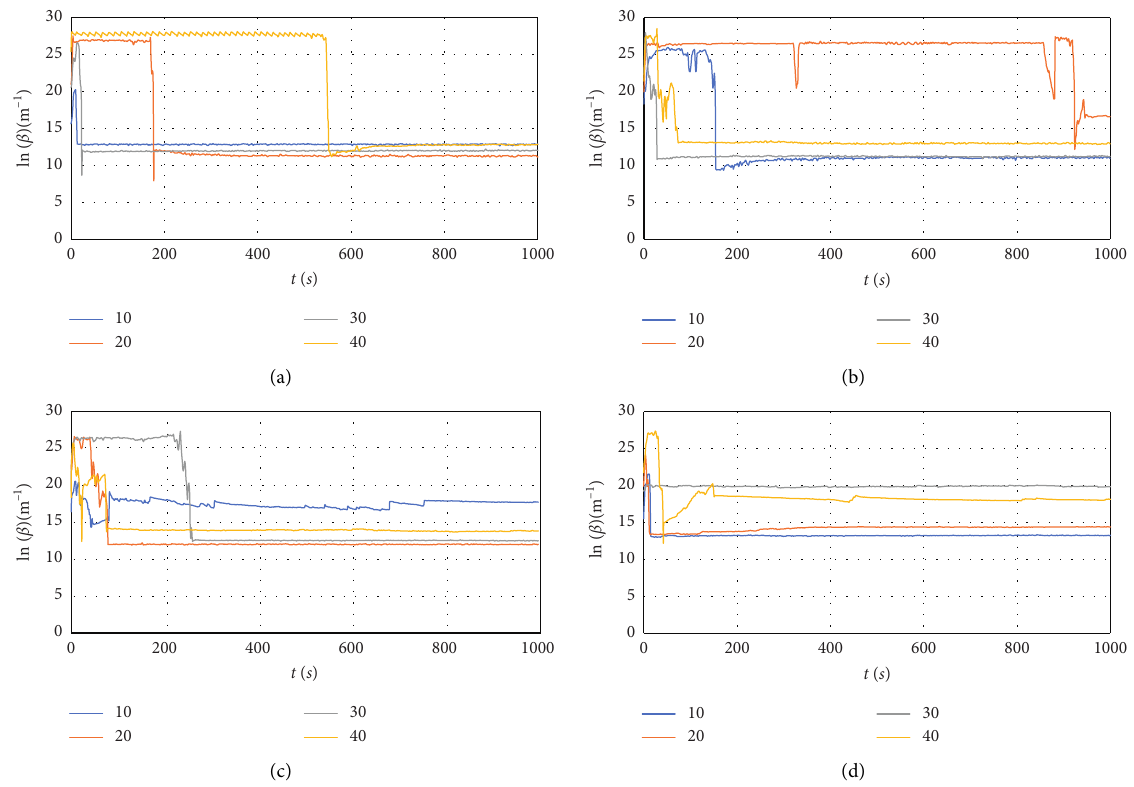
Figure 5: The non-Darcy factor of samples with different gradation under different compaction levels varied with time. (a) n � 0.4. (b) n � 0.5. (c) n � 0.6. (d) n � 0.7.